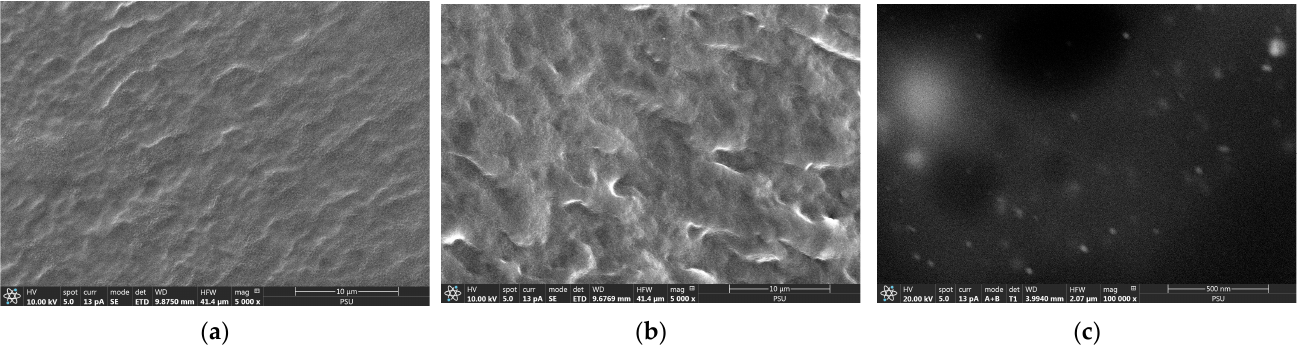
Figure 13. Cross-sectional morphologies of the blank film ( a ) at 5000× and topical film containing silver-nanoparticle-complexed G. applanatum ( b ) at 5000× and ( c ) 100,000×.